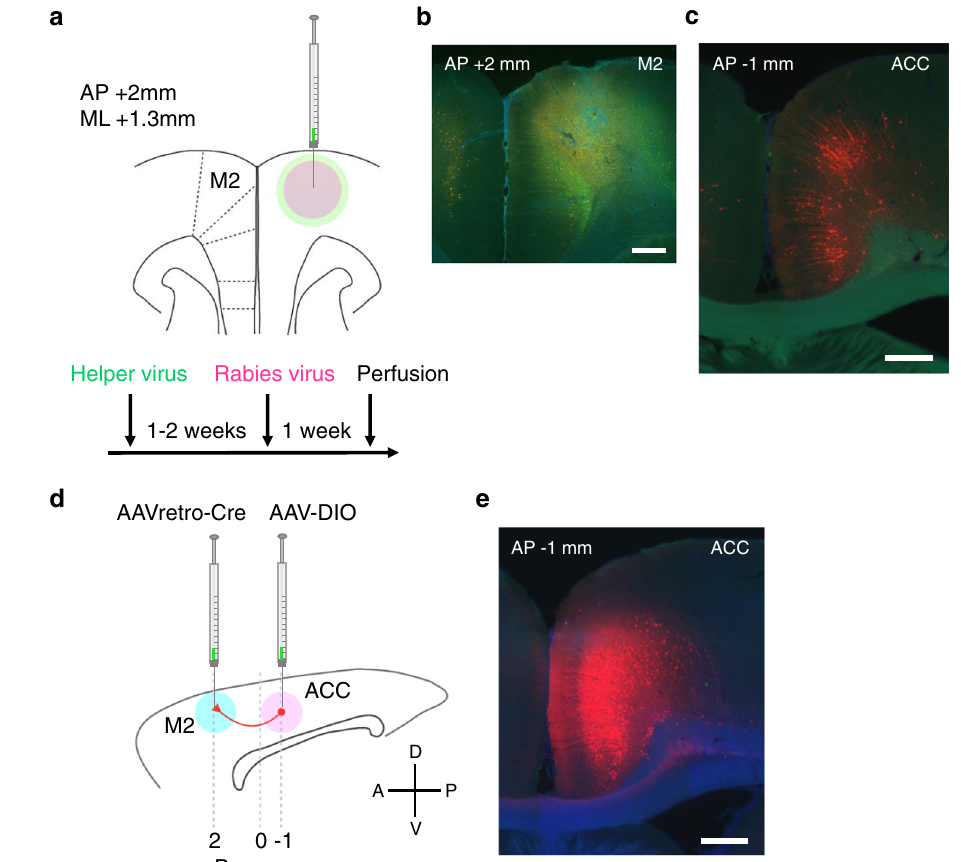
Fig. 3 | Anatomical projections from ACC to M2. a Anatomical projections from ACCtoM2werevisualizedusing ageneticallymodi fi ed rabiesvirussystem.Oneto twoweeksafterhelpervirusinjectioninM2(acocktailsolutionofAAV1-synP-FLEX- sTpEpB and pENN.AAV.CaMKII.0.4.Cre.SV40), rabies virus (RV Δ G-4mCherry) was injectedatthesamecoordinate. b AcoronalsectionofthevirusinjectionsiteinM2 (this is a magni fi ed view of a region pointed by the red arrow in panel no. 4 in Supplementary Fig. 8a). Neurons infected by helpervirus expressed GFP(codedin